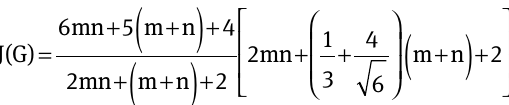
Table 6: Comparison of ENT